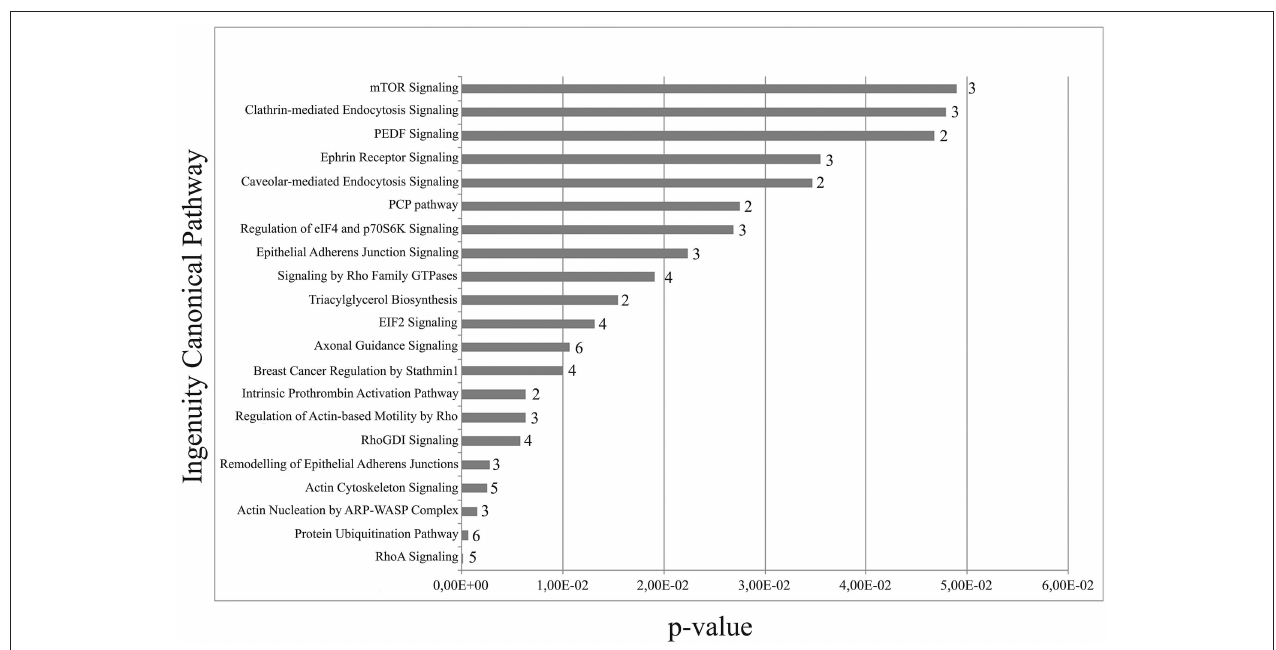
FIGURE 4 | Comparison of ns-Zr15 vs ns-Zr15 hypo. IPA canonical pathways enrichment analysis of ns-Zr15 vs ns-Zr15